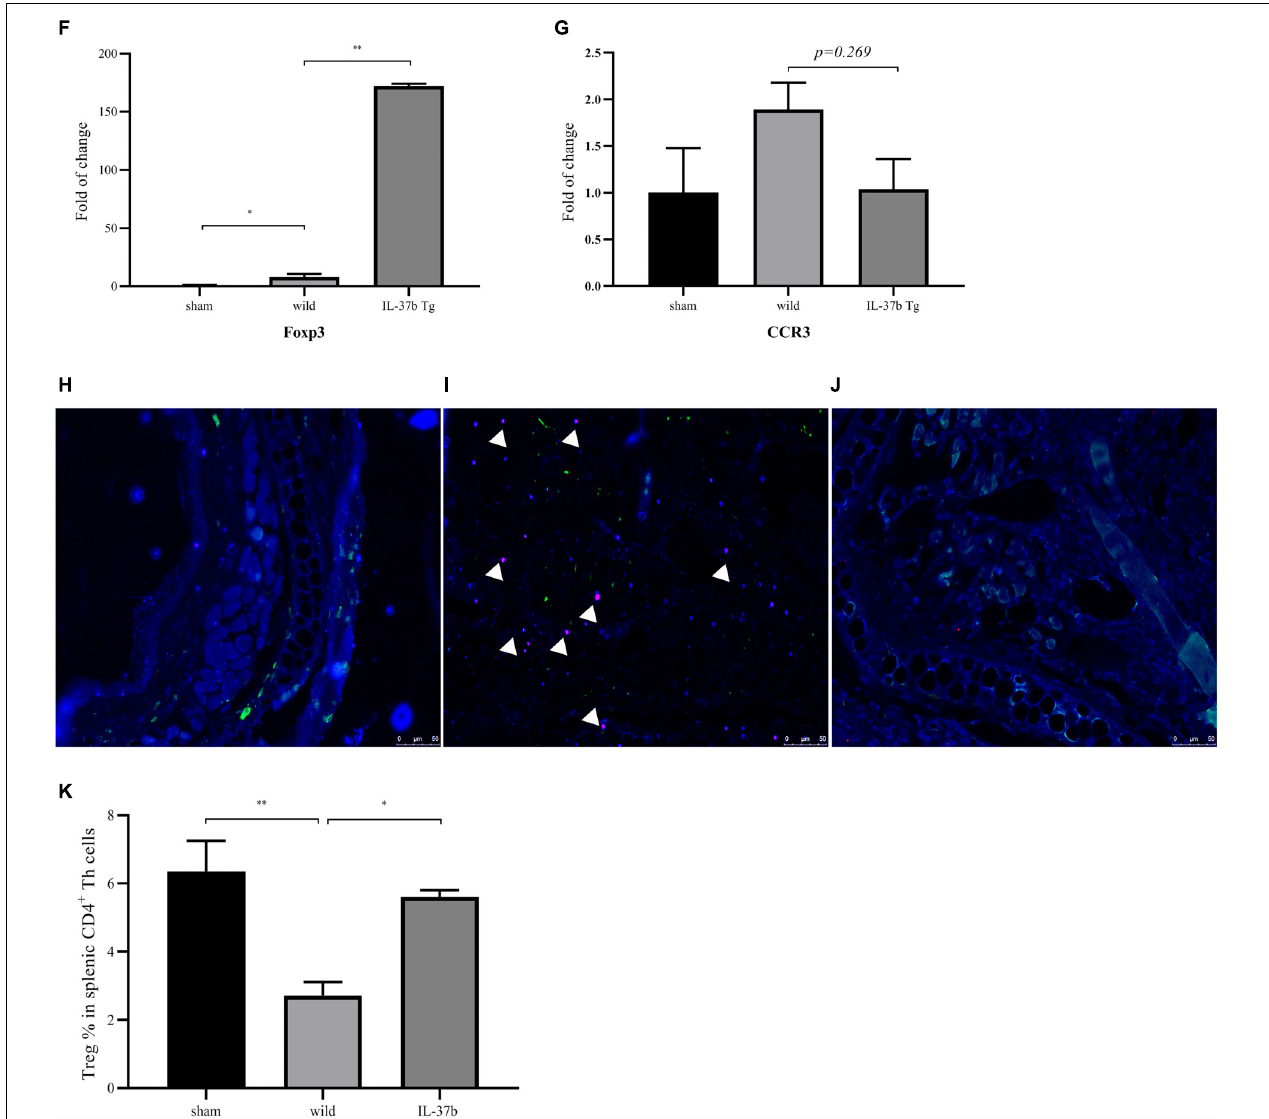
FIGURE 3 | Histological assessment of AD-like skin lesions and immune cell recruitment in ear lesion tissue and spleen. (A) Ear swelling and H&E staining of (B) Sham, (C) Wild type, (D) IL-37 Tg in AD-like skin lesions, (E) Snatching time of wild type and IL-37b Tg mice upon MC903 stimulation. mRNA expression of (F) Foxp3 and (G) CCR3 of wild type and IL-37b Tg mice upon MC903 stimulation. Immunohistofluorescence analysis of eosinophils and dermal fibroblasts by co-staining of dermal fibroblasts and eosinophils using the anti-Vimentin (green) and anti-MBP (red; white triangle pointed) antibodies, respectively. Nuclei were visualized by DAPI (blue) staining. (H) Sham; (I) Wild type mice with MC903 stimulation; (J) IL-37b Tg mice with MC903 stimulation. (K) % of Treg cells in splenic CD4+ Th cells of different groups. Bar charts are shown as mean ± SEM ( n = 6 mice). * P < 0.05 and ** P < 0.01 when compared between the denoted